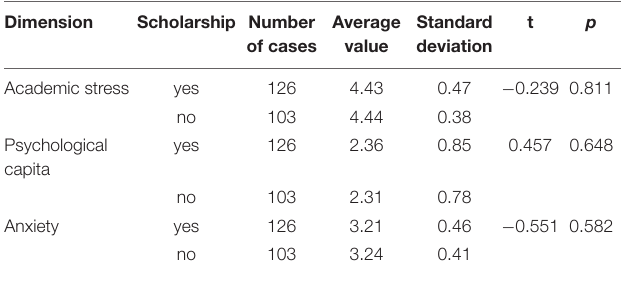
TABLE 7 | Test results of differences in academic stress, psychological capital and anxiety whether you have won a scholarship.